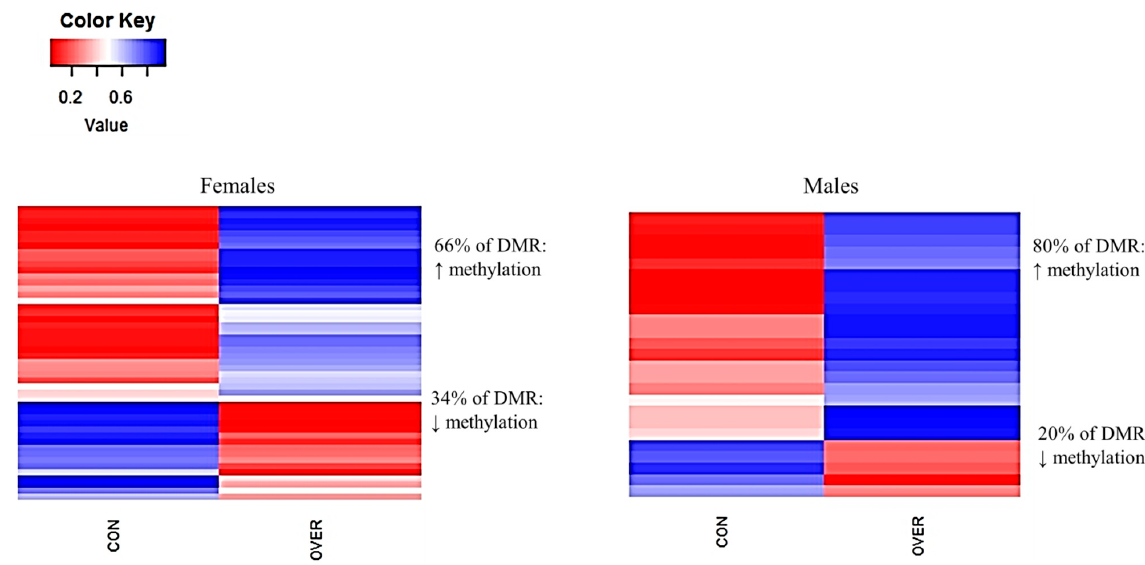
Figure 6. Maternal over-nutrition during gestation increases DNA methylation in male and female offspring. Fe- tuses collected from control- and over-fed ewes at d 135 of gestation are referred to as CON and OVER, respectively. Blue = hypermethylated; red = hypomethylated. Regions were considered differentially methylated when p ≤ 0.001 and ∆ =